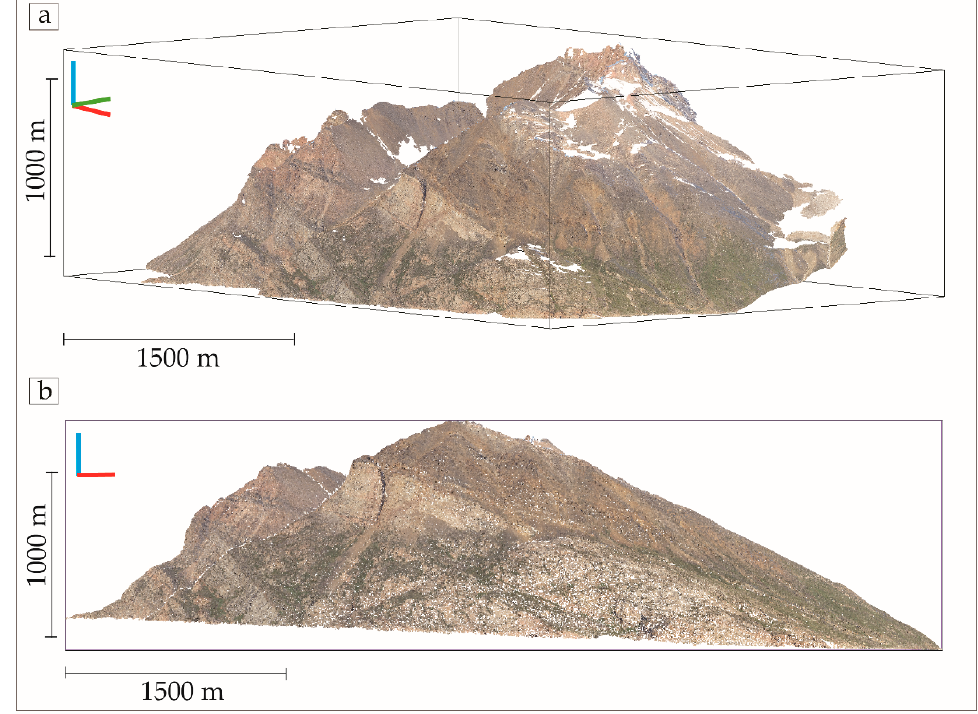
Figure 6. ( a ) Orthographic view of the interpolated point cloud for Karrat, where x, y and z axes are indicated by red, green and blue colors, respectively; and ( b ) generated pseudo-orthophoto from view-based projection of 3D point cloud.